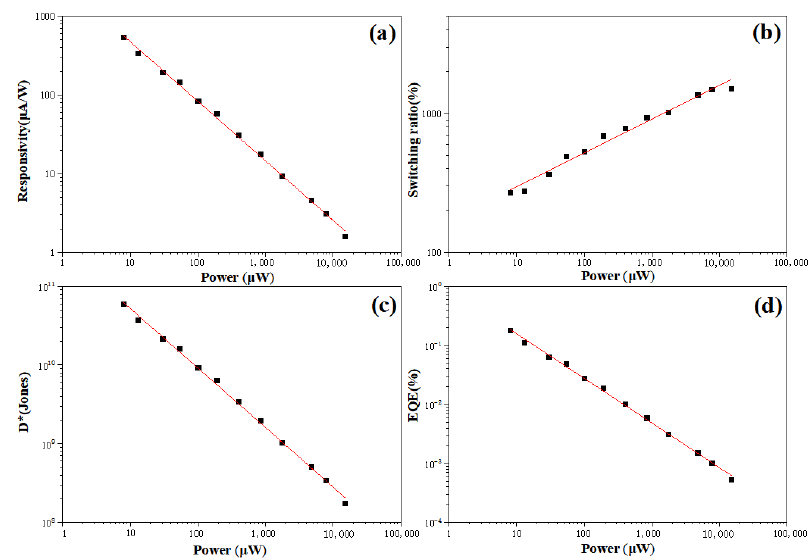
Figure 4. Fitting p hotoresponse characteristics of HDA-BiI 5 -based photodetectors under 375 nm laser: ( a ) photoresponsiv- ity, ( b ) switching ratio, ( c ) specific detectivity, ( d ) External quantum efficiency. To further investigate the effect of wavelengths of laser on the photoelectric perfor- mance of the detector, we use 532 nm wavelength laser for the photoelectric performance test. The photoresponse characteristics curve of the photodetector without electron transport layer under zero-bias 532 nm laser with a switching time of 1 s is shown in Fig- ure 5a. At the same light power, the photocurrent basically does not vary with the switch- ing time, and there is a very low dark current which contributes significantly to the device stability. The response time curve of HDA-BiI 5 -based photodetectors under laser irradia- tion at 532 nm, 49.4 mW power is shown in Figure 5b. We take 10%–90% of the response as rise time and 90%–10% as decay time. It can be seen that the device rise time is about 62 ms and decay time is about 63 ms. However, the value of the photocurrent decreases compared to the 375 nm laser irradiation, and it can be seen from Figure 5b that the re- sponse is slower in the no-light-to-light process. This may be related to the transport speed and transport efficiency of electrons and holes in the PN junction, which eventually leads to a longer rising time from no light to light in the photoelectric device.